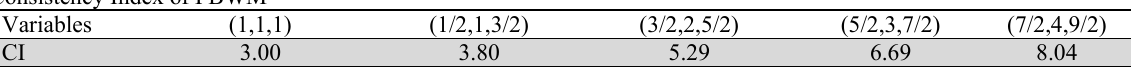
Consistency Index of FBWM